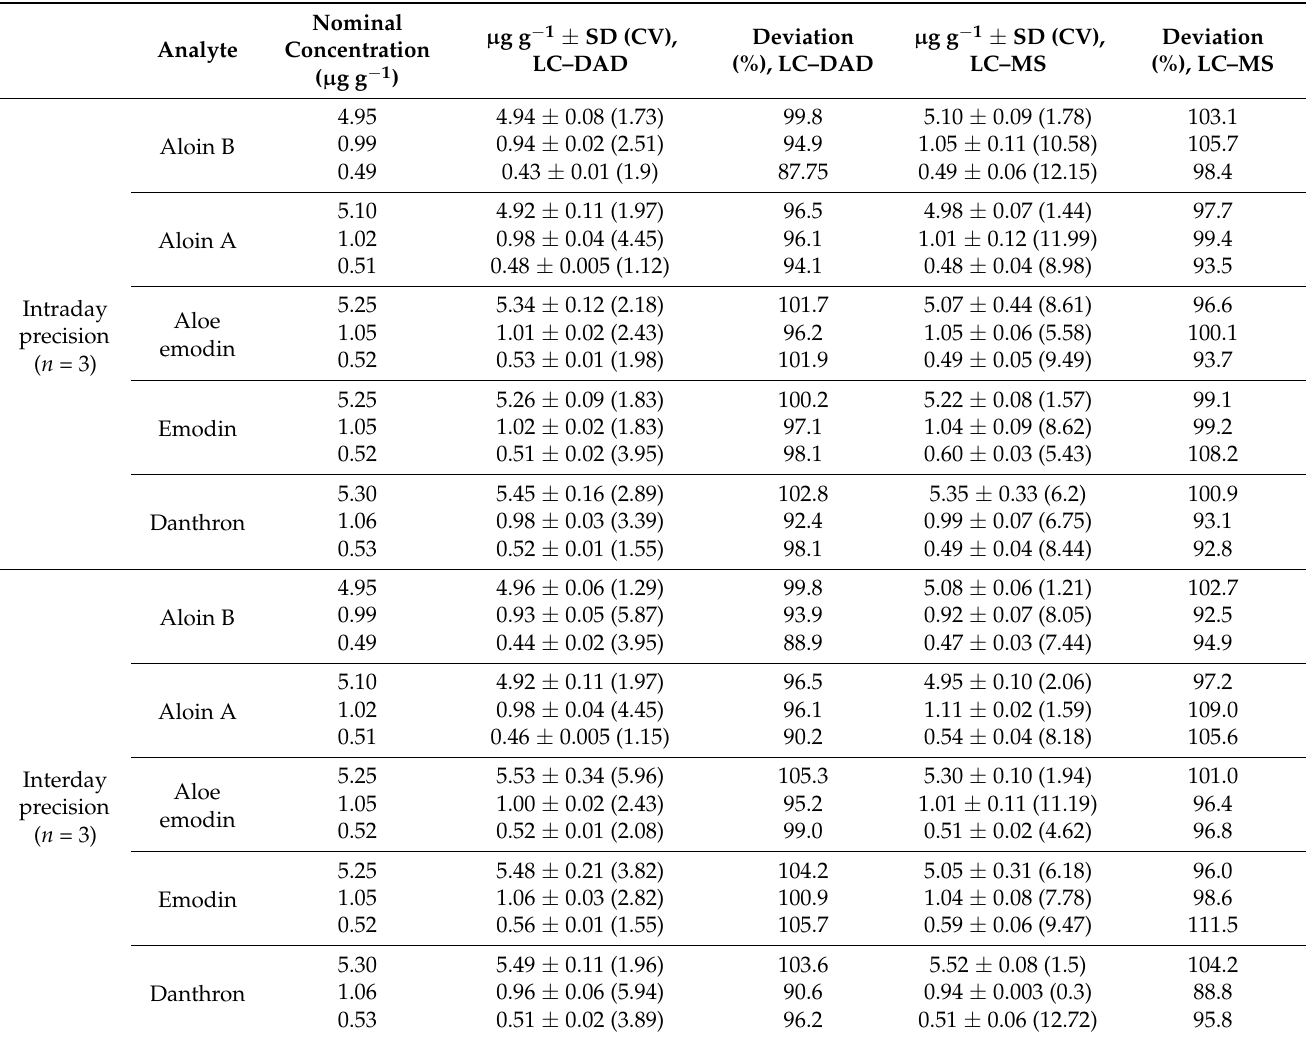
Table 2. Intraday and interday precision and deviation of HADs at different concentrations, measured by LC–DAD and LC–MS.